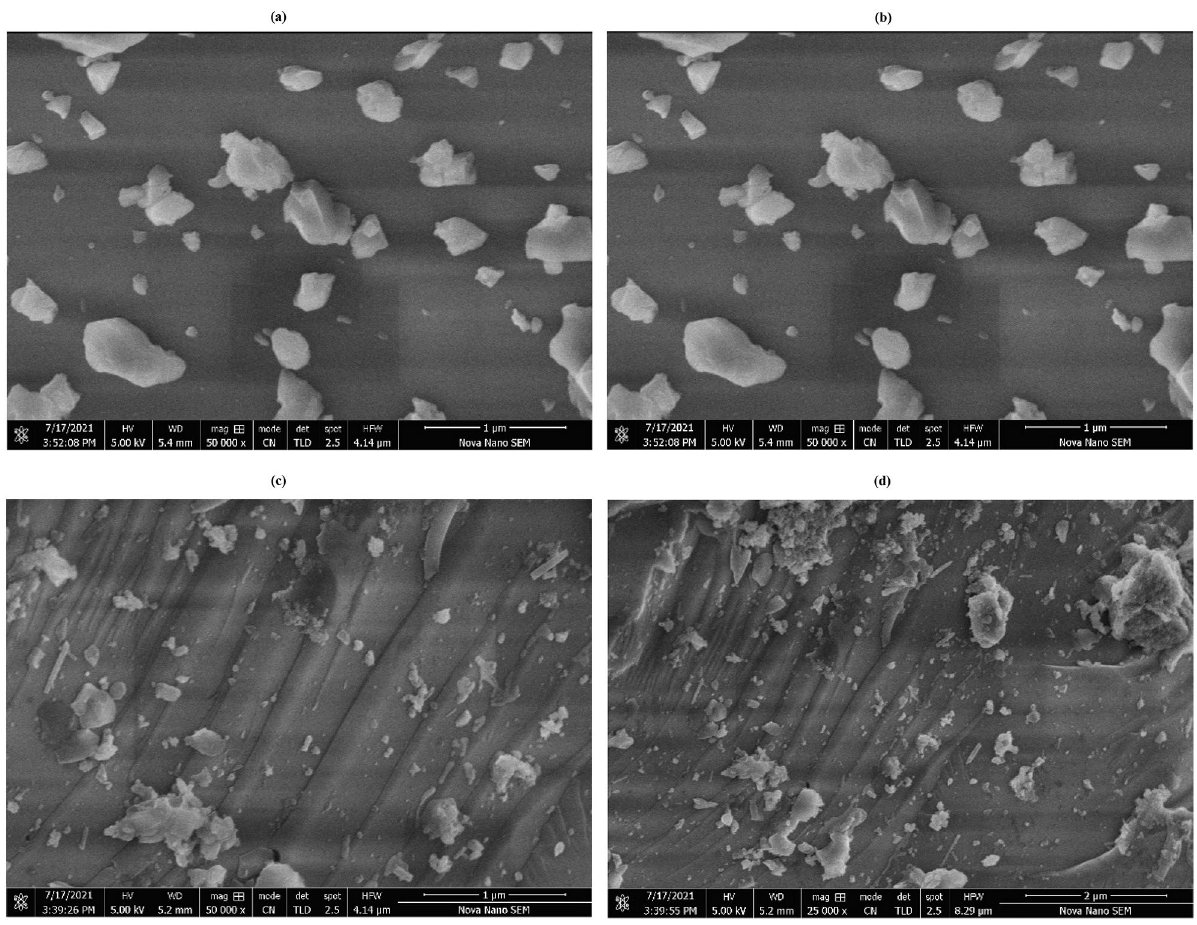
Figure 4. SEM images of ( 1a ) Feldspar at 1 µm ( 1b ) Feldspar at 2 µm; ( 2a ) Fe/SnO/Feldspar at 1 µm ( 2b ) Fe/ SnO/Feldspar at 2